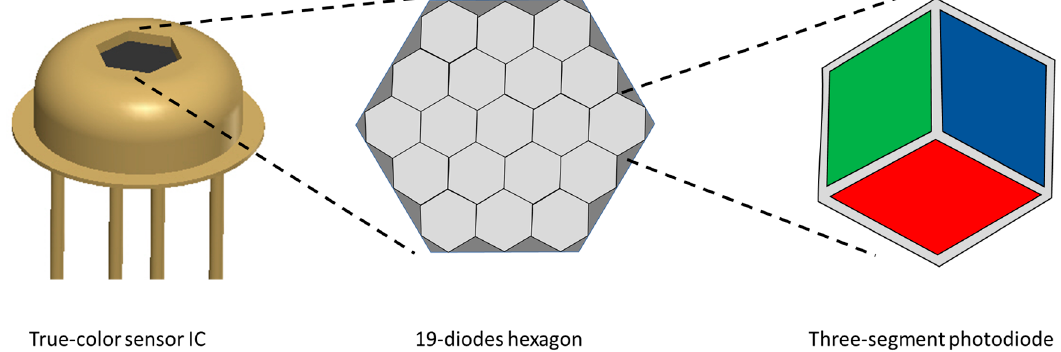
Figure 1. Nineteen-diode hexagon sensor IC with three segment photodiodes for color detection. The sensor was equipped with a double concave lens with a screen diameter of 50 mm (Figure 2). The spot size is about 20 cm 2 .